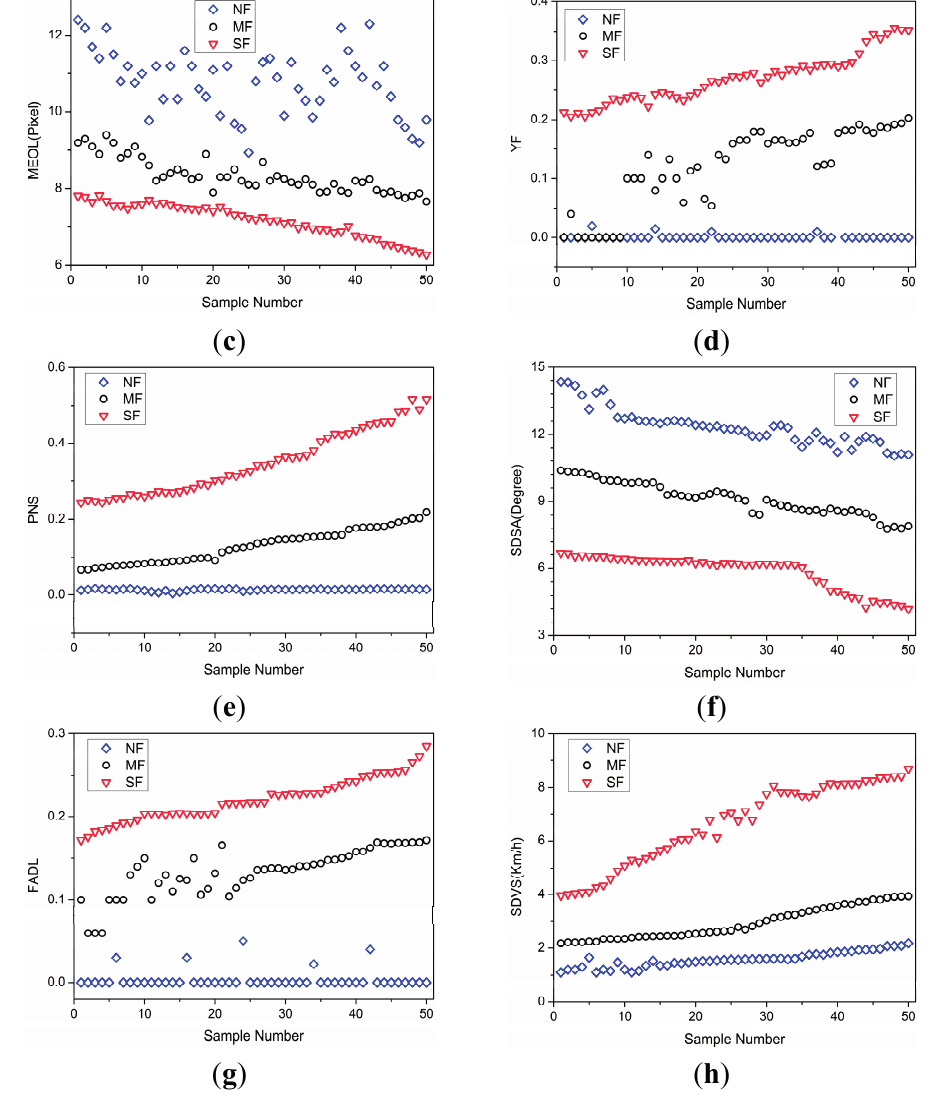
Figure 4. Fatigue feature measurement. ( a ) F measurement; ( b ) ECD measurement; ( c ) MEOL measurement; ( d ) YF measurement; ( e ) PNS measurement; ( f ) SDSA measurement; ( g ) FADL measurement; ( h ) SDVS